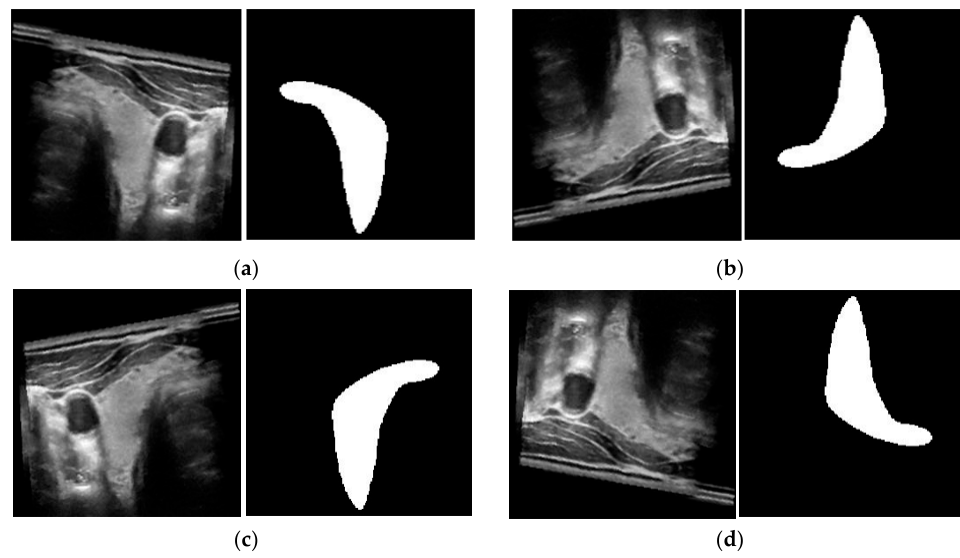
Figure 9. Examples of resulting images after data augmentation method used in our experiments: ( a ) original image pair (image and ground-truth mask); ( b ) vertically flipped images of ( a ); ( c ) horizontally flipped images of ( a ); ( d ) horizontally and vertically flipped images of ( a ).